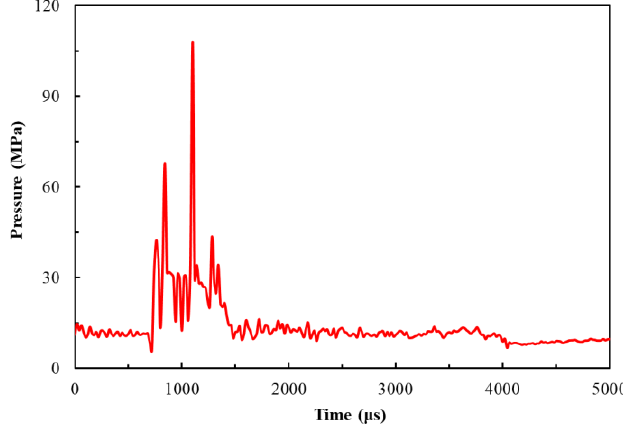
Figure 6. Simulated perforation pressure-time curve.